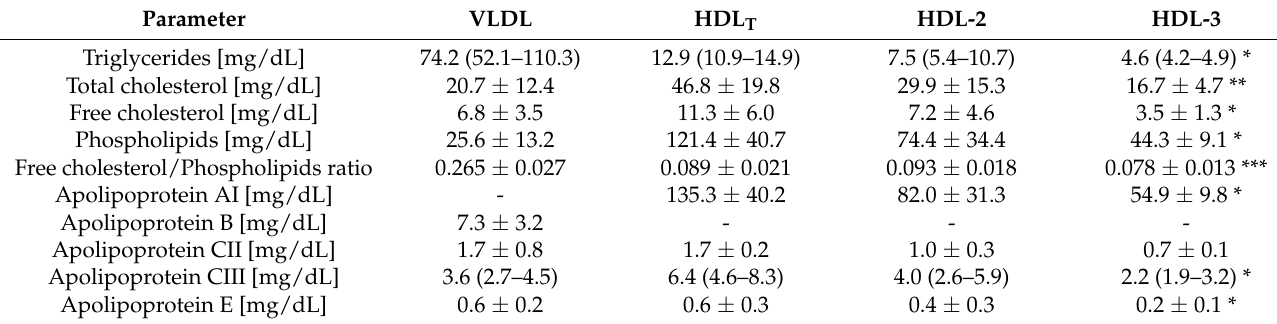
mixture contained VLDL, albumin and the incubation buffer (described above). Table 1. Lipid and apolipoprotein composition of VLDL, HDL T , and HDL-2 and HDL-3 subpopulations. Data are presented as mean ± SD or median with 25th and 75th percentiles (n = 10), * p < 0.05, ** p < 0.01, *** p < 0.001, compared to HDL-2.